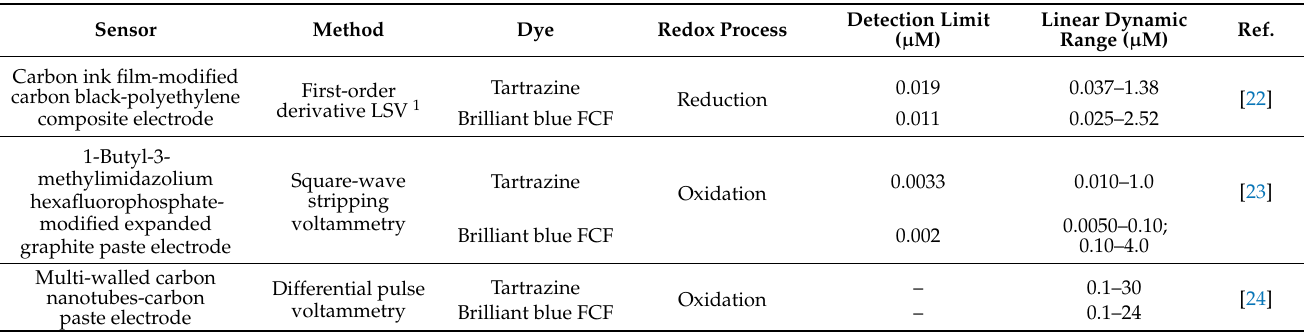
Table 1. List of merits of electrochemical sensors for the simultaneous determination of tartrazine and brilliant blue